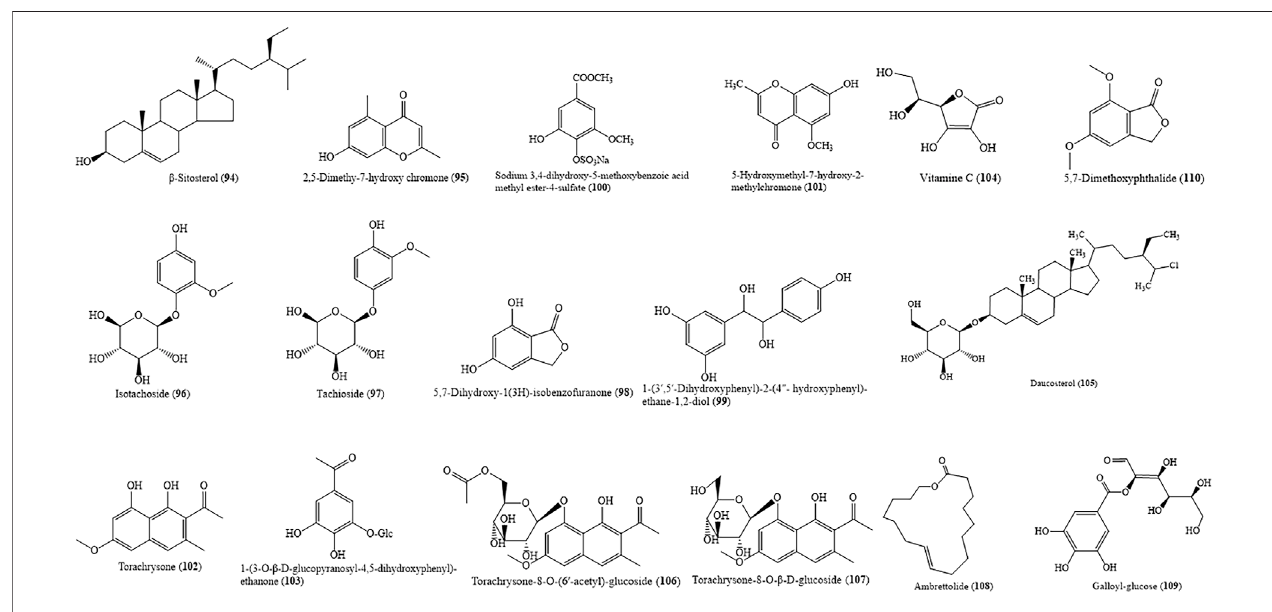
FIGURE 8 | Major others presenting in